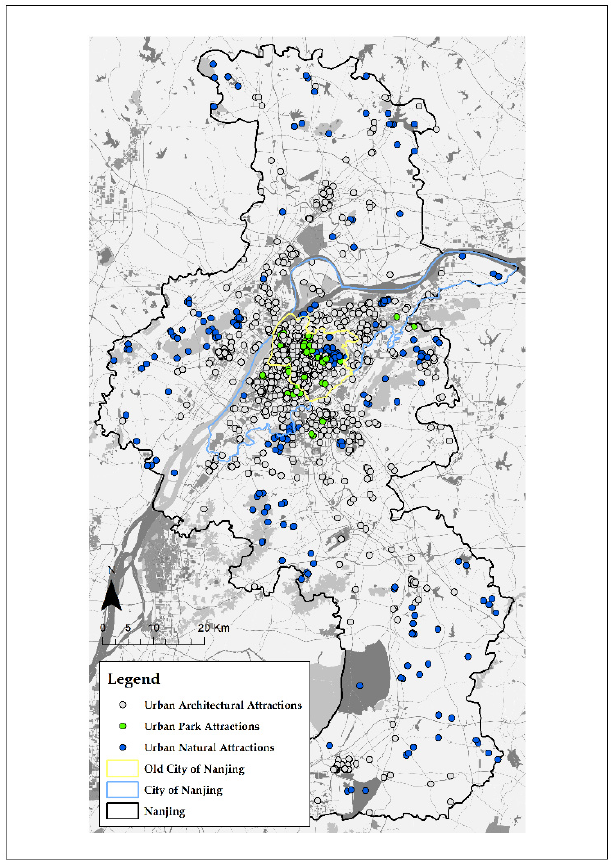
Figure 4. The location and cluster of attractions in Nanjing.